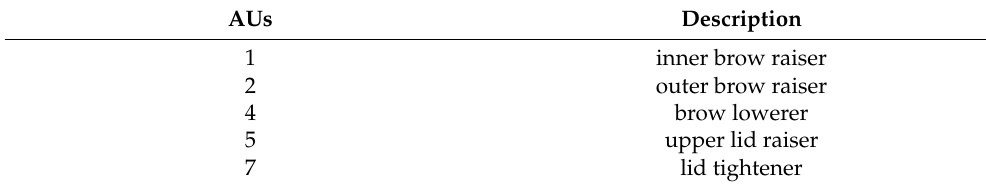
Table 1. Description of facial action units (AUs) used in the study.